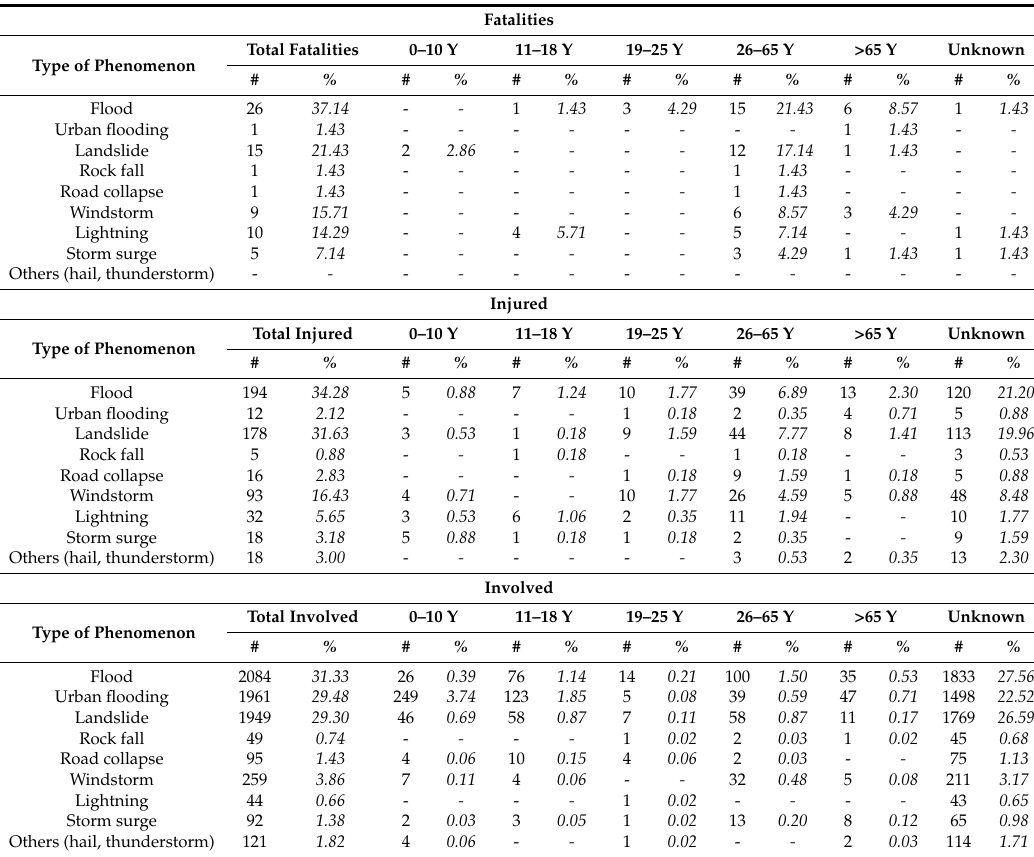
Table A1. Relationships between classes of age and types of phenomenon.